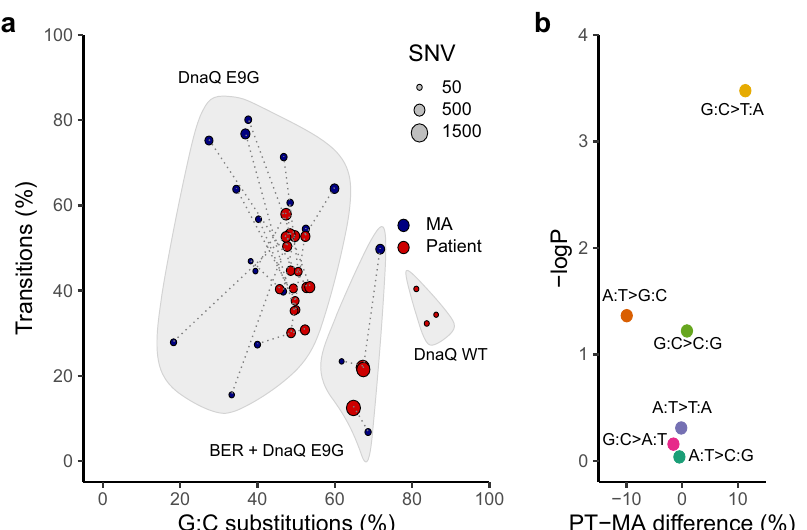
Fig. 5 Distinct mutation signatures observed in patient isolates reveal impacts of DnaQ and base excision repair pathway genotypes and oxidative stress. a Relative transition and GC substitution frequencies in patient isolates (red dots) and in mutation accumulation experiments (blue dots). Dot size represents a divergence from an ancestor (SNVs) and matching isolates are connected by a dashed line. Three distinct groups de fi ned by DnaQ and base excision repair (MutM or MutY) mutations are indicated. Isolate 1G1 is not included in the fi gure due to the small number of mutations. b Mean differences in the relative frequency of base-pair substitutions for mutations observed in patient isolates vs. MA experiment. The vertical axis indicates the negative log 10 of the calculated P values (two-sided Wilcoxon test) for the indicated base-pair substitution. A signi fi cant excess of G:C > T:A substitutions is present in the patient isolates, suggesting that oxidative stress played a major role in shaping in vivo evolution. Source data are provided as a Source Data fi